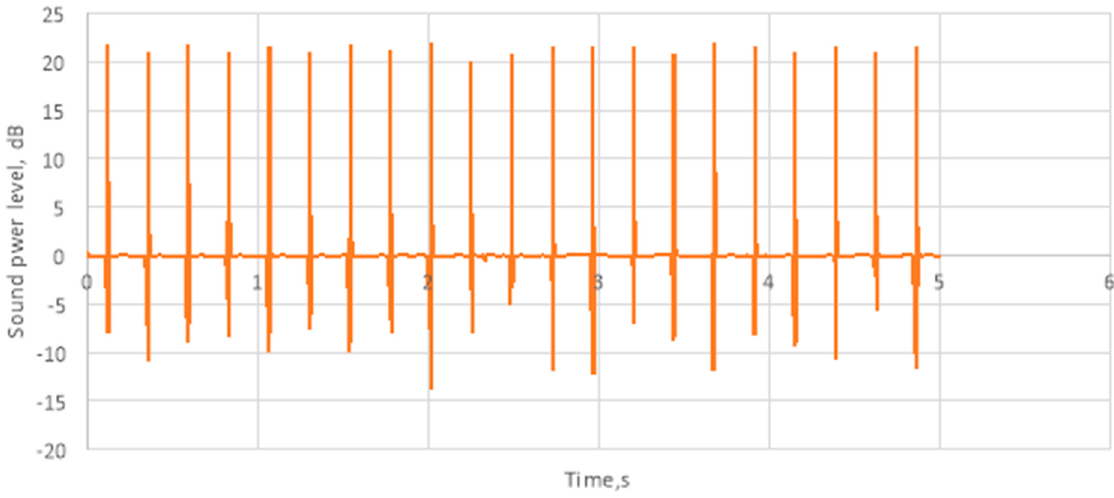
Figure 15. Calculated sound power level values of the 85th wheelset.